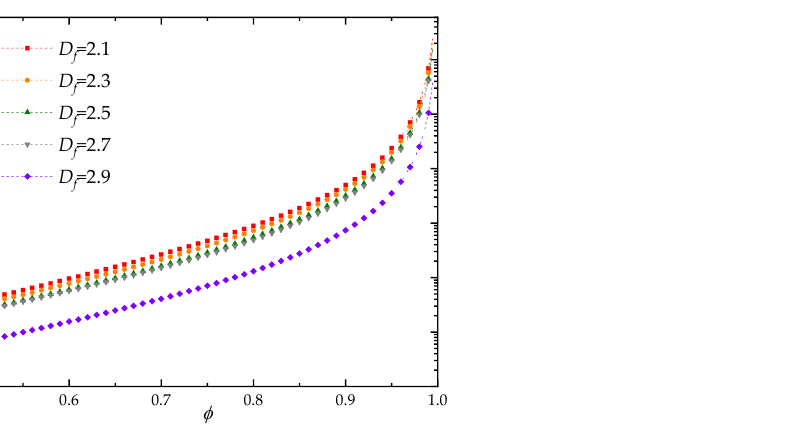
Figure 8. The effect of pore fractal dimension on the dimensionless through-plane permeability of fibrous porous material.